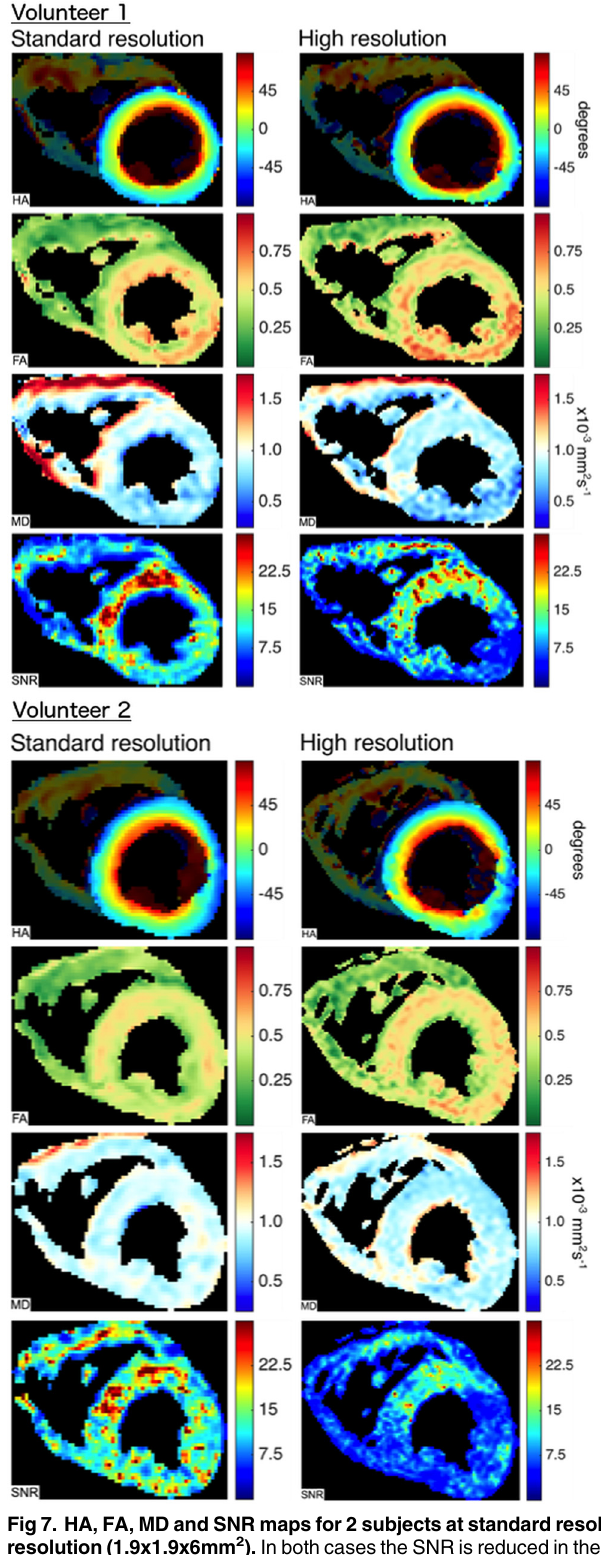
Fig 7. HA, FA, MD and SNR maps for 2 subjects at standard resolution (2.8x2.8x8mm 2 ) and higher resolution (1.9x1.9x6mm 2 ). In both cases the SNR is reduced in the higher resolution scan, especially in